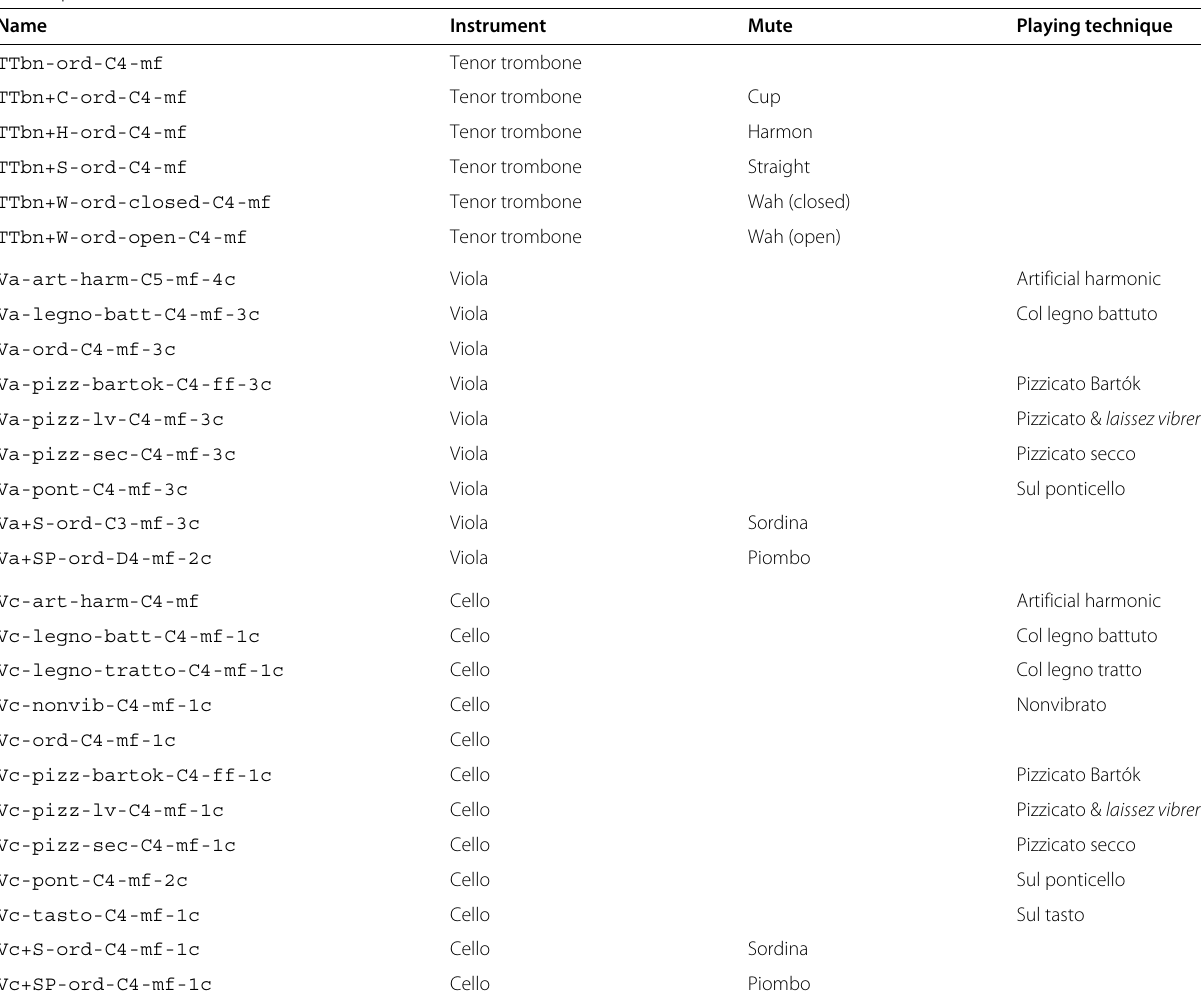
Table 1 Full list of audio stimuli (1/2). In each instrument, a blank space in the rightmost column denotes the ordinary playing technique ( ordinario ). ( Continued)